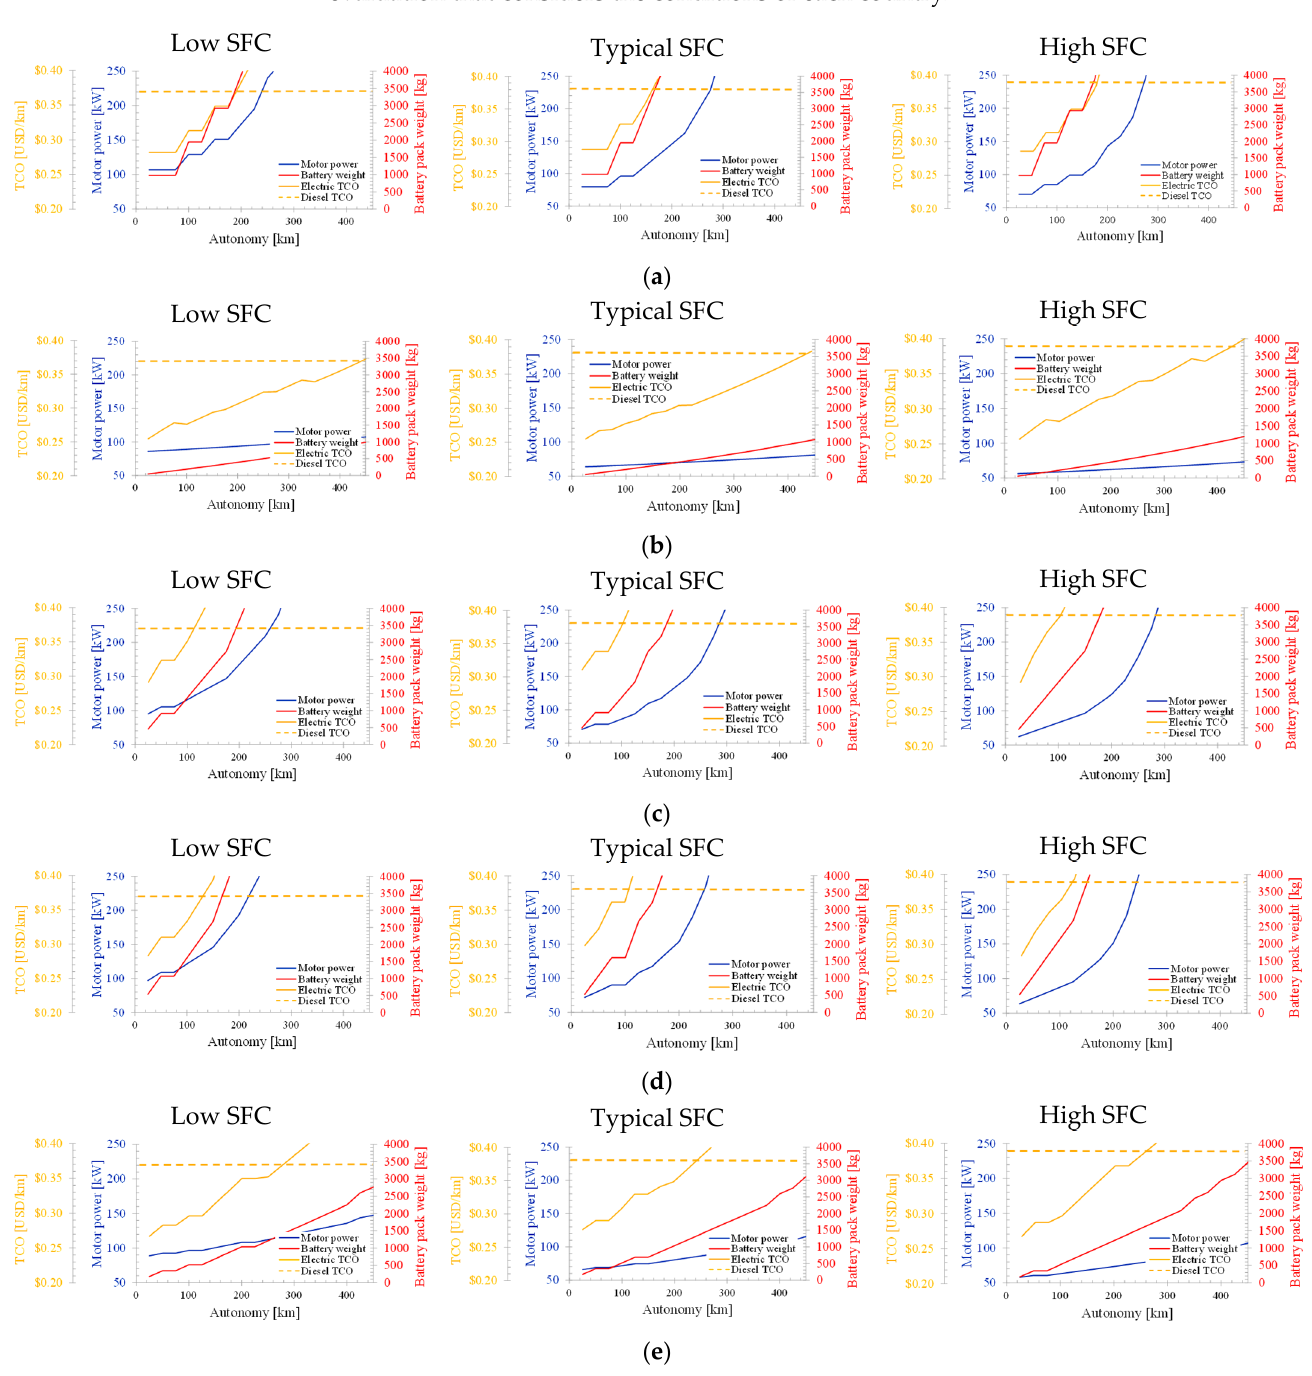
Figure 11. Impact of the desired autonomy on the TCO due to changes in motor and battery pack requirements considering ( a ) deep-cycle lead acid, ( b ) Li-Ion, ( c ) Na-NiCl 2 , ( d ) Ni-MH, and ( e ) lithium-sulfur batteries for low SFC, typical SFC, and high SFC scenarios.